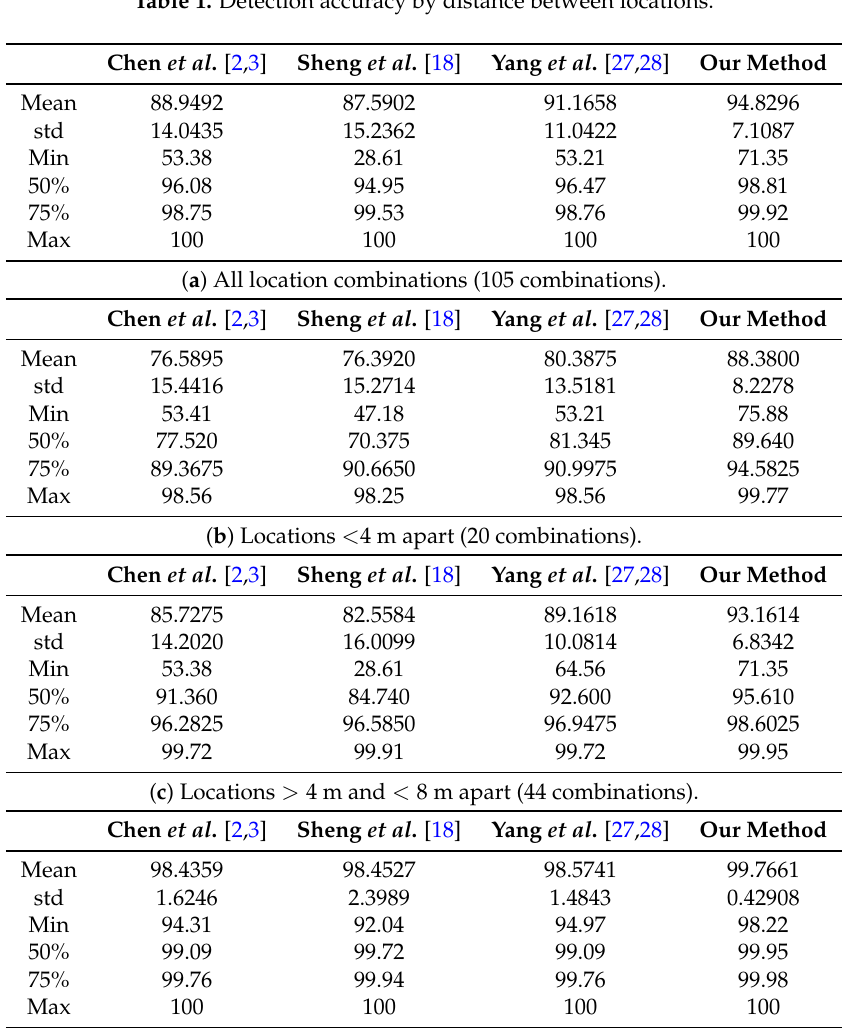
Table 1. Detection accuracy by distance between